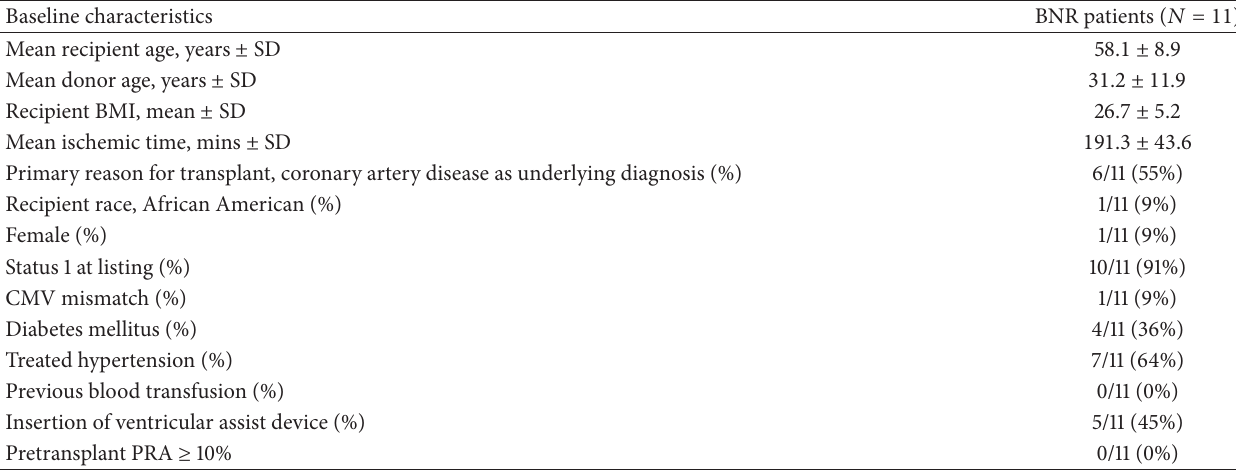
Table 1: Baseline characteristics of the patients with treated BNR.